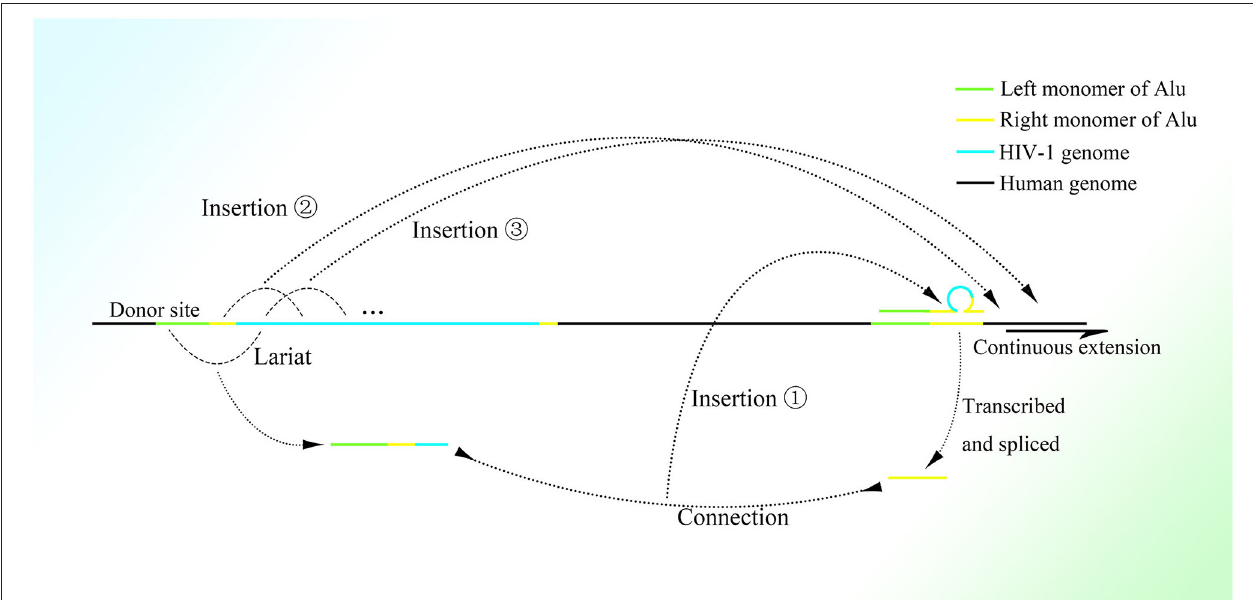
FIGURE 2 | The possible mechanism of insertion of the HIV-1 genome into the right monomer of the Alu element. A lariat containing the left monomer of the Alu element, part of the right monomer, and the 5 ′ sequence of the HIV-1 genome would be produced and connected to the right monomer of Alu transcribed and spliced nearby. Then the 5 ′ region of the HIV-1 genome would be inserted into the right part of another Alu element nearby with the assistance of the lariat-Alu complex. The remaining HIV-1 genome downstream would be gradually inserted at the new insertion site within another Alu